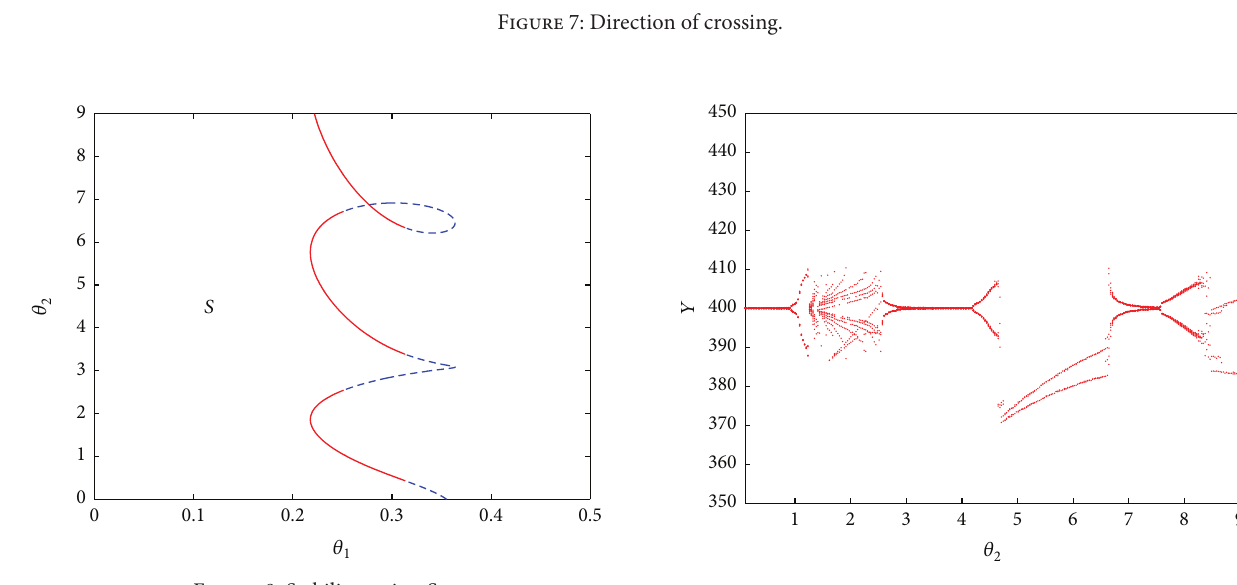
these effects. Hence, we resort to a numerical method. Based on the parameter values proposed in Section 3.2, crossing curves 𝜃 20 can be described within each range of 𝐼 𝑌 and 𝜔 ∗ , as shown in Figure 14. 𝐼 𝐾 that ensure the existence of The region located below these curves indicates the stability regions. Similar to the case with no policy lags, an